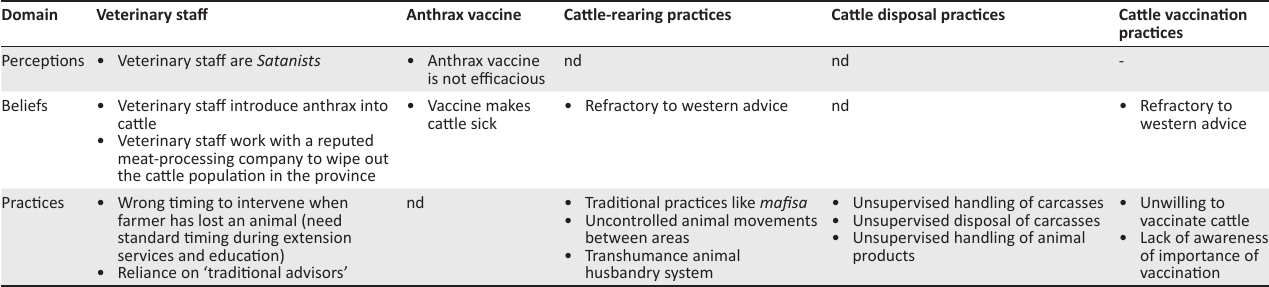
TABLE 1: Barriers identified to affect anthrax outbreaks in the Western Province of Zambia. Domain Veterinary